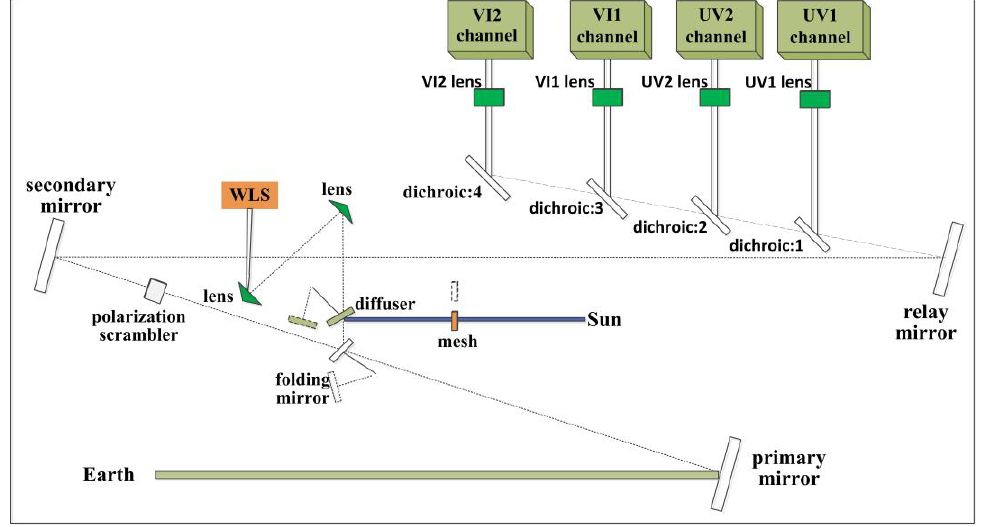
Figure 1. EMI-2 optical layout.